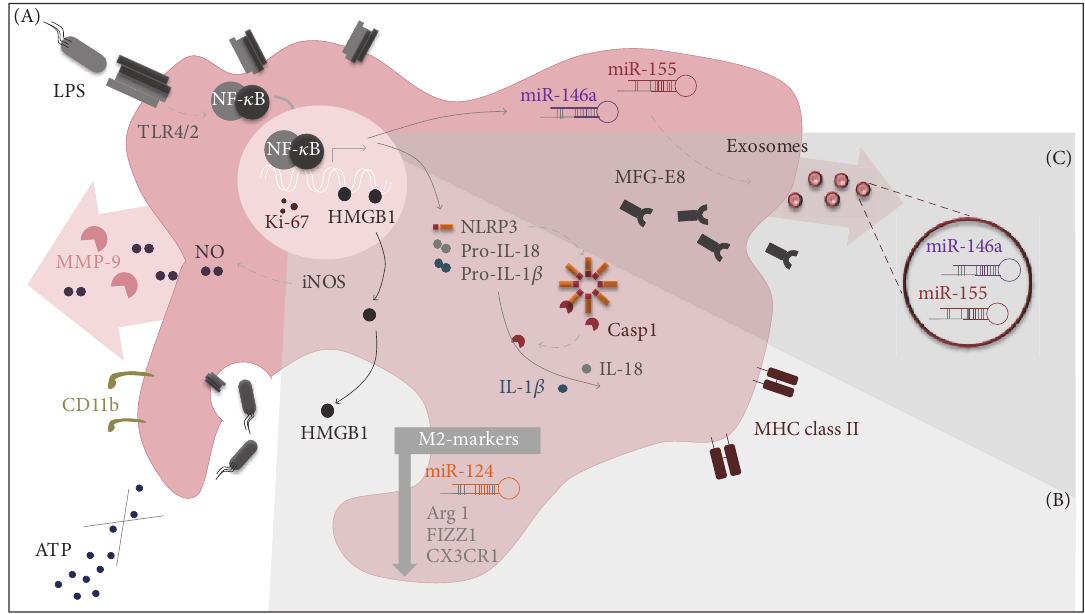
Figure 8: Schematic representation of inflammatory players implicated in lipopolysaccharide- (LPS-) induced M1 polarization of N9 microglial cells and of exosome upregulated microRNAs. (A) We first studied functions and pathways commonly described for microglia classical activation. We observed that LPS causes a moderate degree of apoptosis in the N9 cells and a switch from the ramified to an amoeboid cell shape. LPS-stimulated cells lose the ability to migrate towards ATP but show increased phagocytic ability, as revealed by the elevated number of latex beads ingested. LPS also triggers microglia proliferation as indicated by the increased number of Cd11b positive cells and Ki-67 stained nuclei. Inflammatory events are mediated through the signaling pathway involving the toll-like receptor 4 (TLR4)/TLR2 and nuclear factor kappa B (NF- 𝜅 B) in LPS-treated N9 microglia and implicate the upregulation of microRNA-155 (miR-155) and miR-146a as well as the release of nitric oxide (NO) and matrix metalloproteinase-9 (MMP-9) to the extracellular milieu. (B) Our study provided new evidence that N9 cells treated with LPS have increased expression of inflammasome complex comprehending the upregulation of interleukin- (IL-) 1beta , IL-18, and NOD-like receptor family pyrin domain containing 3 (Nlrp3) , together with enhanced caspase-1 activation. Increased expression of Nos2 and major histocompatibility complex class II (Mhc-II) (markers of M1 polarization or classically activated microglia), in conjunction with decreased expression of arginase 1 (Arg1) , found in inflammatory zone 1 (Fizz1), miR-124 (markers of M2 polarization or alternatively activated microglia), and reduced CX3C chemokine receptor 1 (CX3CR1) expression corroborate the acquisition of a prevalent M1 phenotype in microglial cells exposed to LPS. (C) Finally, we described for the first time that increased MFG-E8 expression and release are induced in M1 polarized microglia and that miRs expression profile is recapitulated in cell-derived exosomes, further supporting M1 polarization in LPS-treated N9 cells and dissemination of inflammatory mediators by extracellular